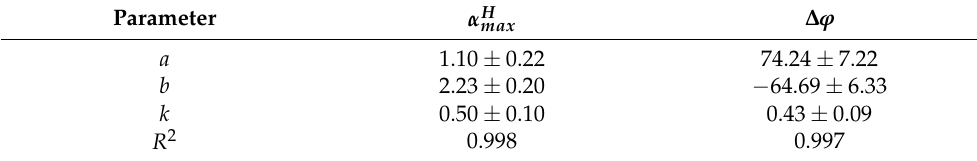
Figure 16. Frequency dependences of the peak value of the ME coupling coefficient α H max and the phase shift ∆ ϕ . Dashed lines indicate fitted exponential functions ( y ( f ) = a + be − kf ), where y is either α H max or ∆ ϕ . Table 3. Parameters of fitted functions in Figure 16. R 2 denotes the determination